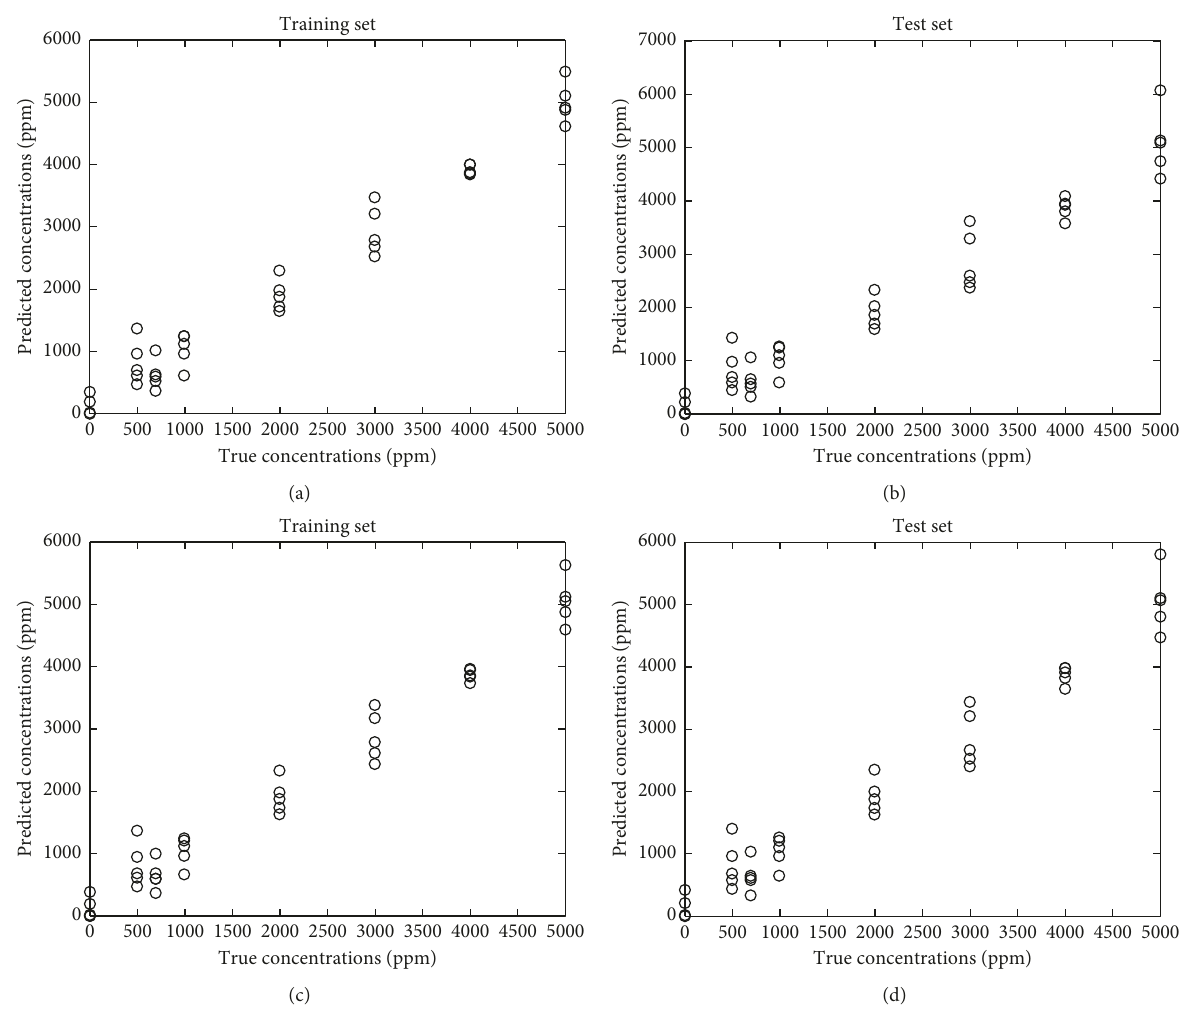
14.08, (b) % RMSE 18.70, (cid:26) (cid:26)